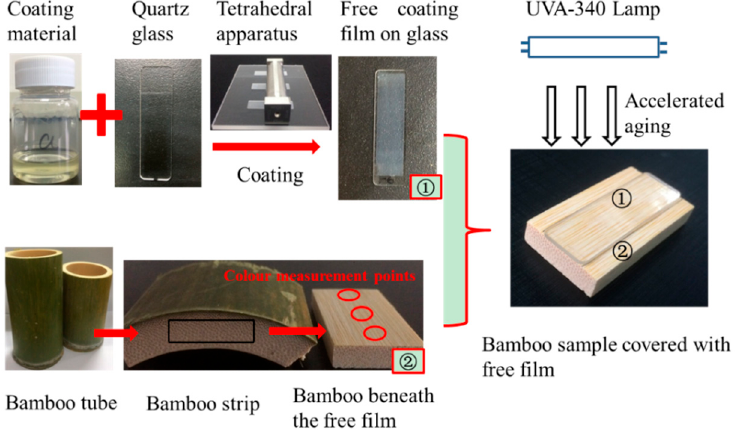
Figure 1. Preparation of samples for the accelerated aging of coated bamboo.